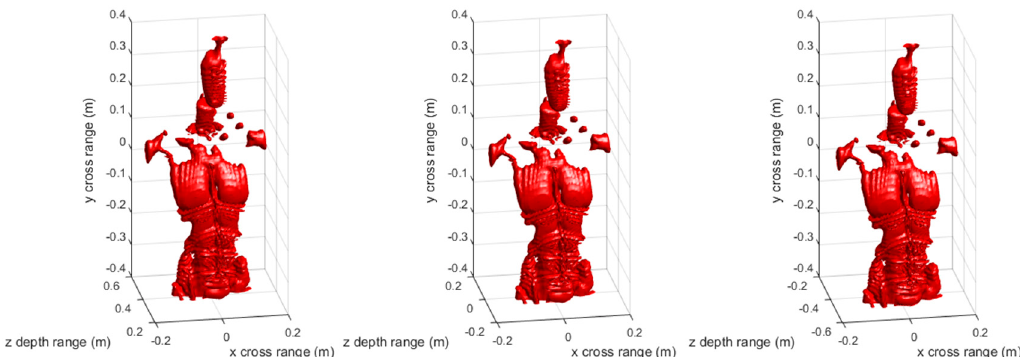
Figure 9. Three-dimentional imaging results of the mannequin by conventional RMA with compensation distance 0 ( left ), 0.43 m ( middle ), and 0.86 m ( right ).